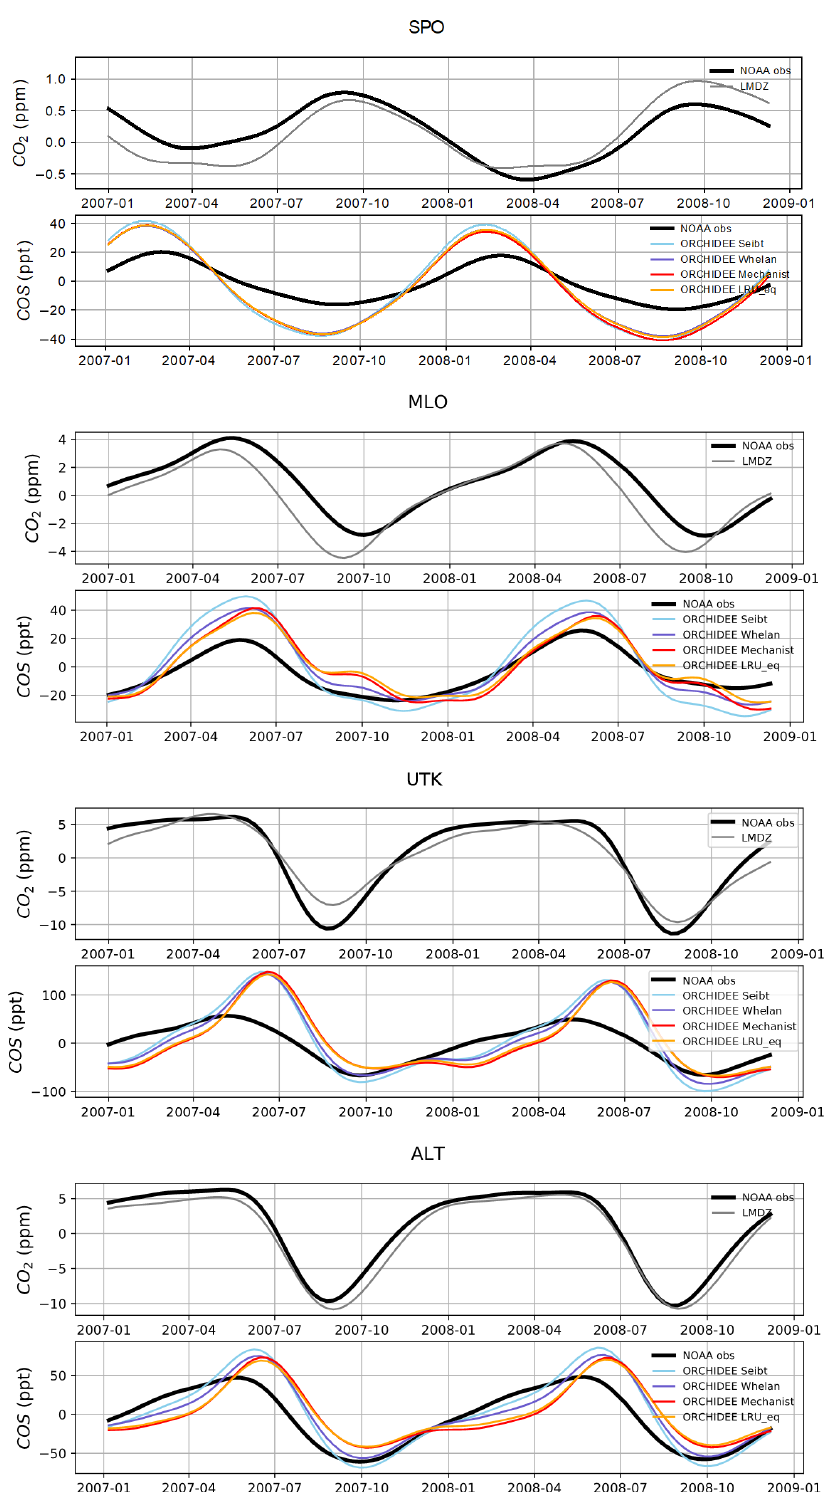
Figure D1. Detrended temporal evolutions of simulated and observed CO 2 and COS concentrations at four selected sites, for the mechanistic (ORCHIDEE Mechanist) and LRU approaches (ORCHIDEE Seibt, ORCHIDEE Whelan, ORCHIDEE LRU_Opt), simulated with LMDz6 transport between 2007 and 2009. The ORCHIDEE LRU_Opt line (orange) corresponds to the concentrations simulated using the optimal LRU values derived from the mechanistic model. The curves have been detrended beforehand and filtered to remove the synoptic variability (see Sect.